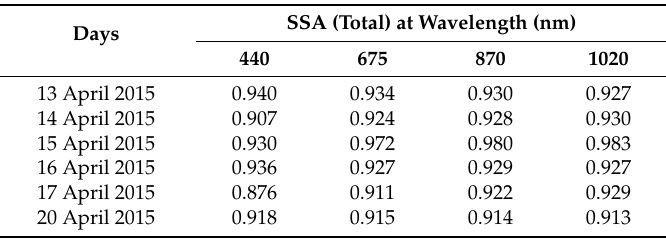
Figure 8. Variations of total mode single scattering albedo during dust storm event. Table 2. Total mode single scattering albedo during dusty day and non-dusty days.